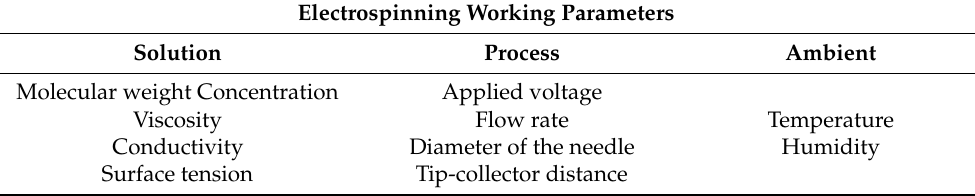
Table 1. Main electrospinning working parameters.